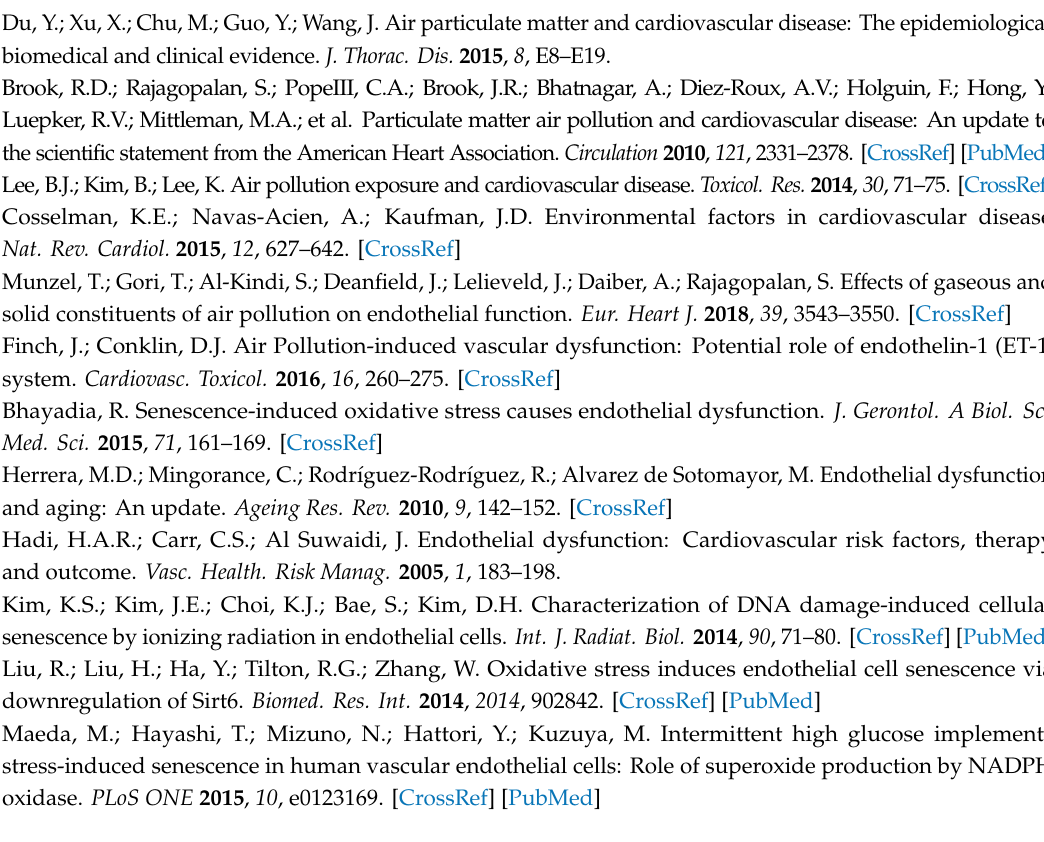
Figure S1: Spectral data for hop prenylated flavonoids isoxanthohumol (IX) and xanthohumol